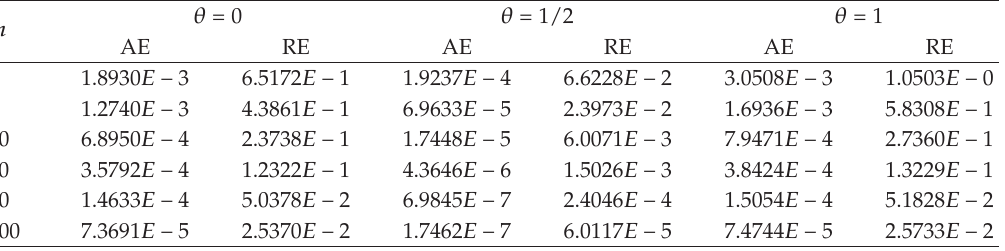
Table 1: Linear θ -methods for problem (cid:4) 5.1 (cid:5) .